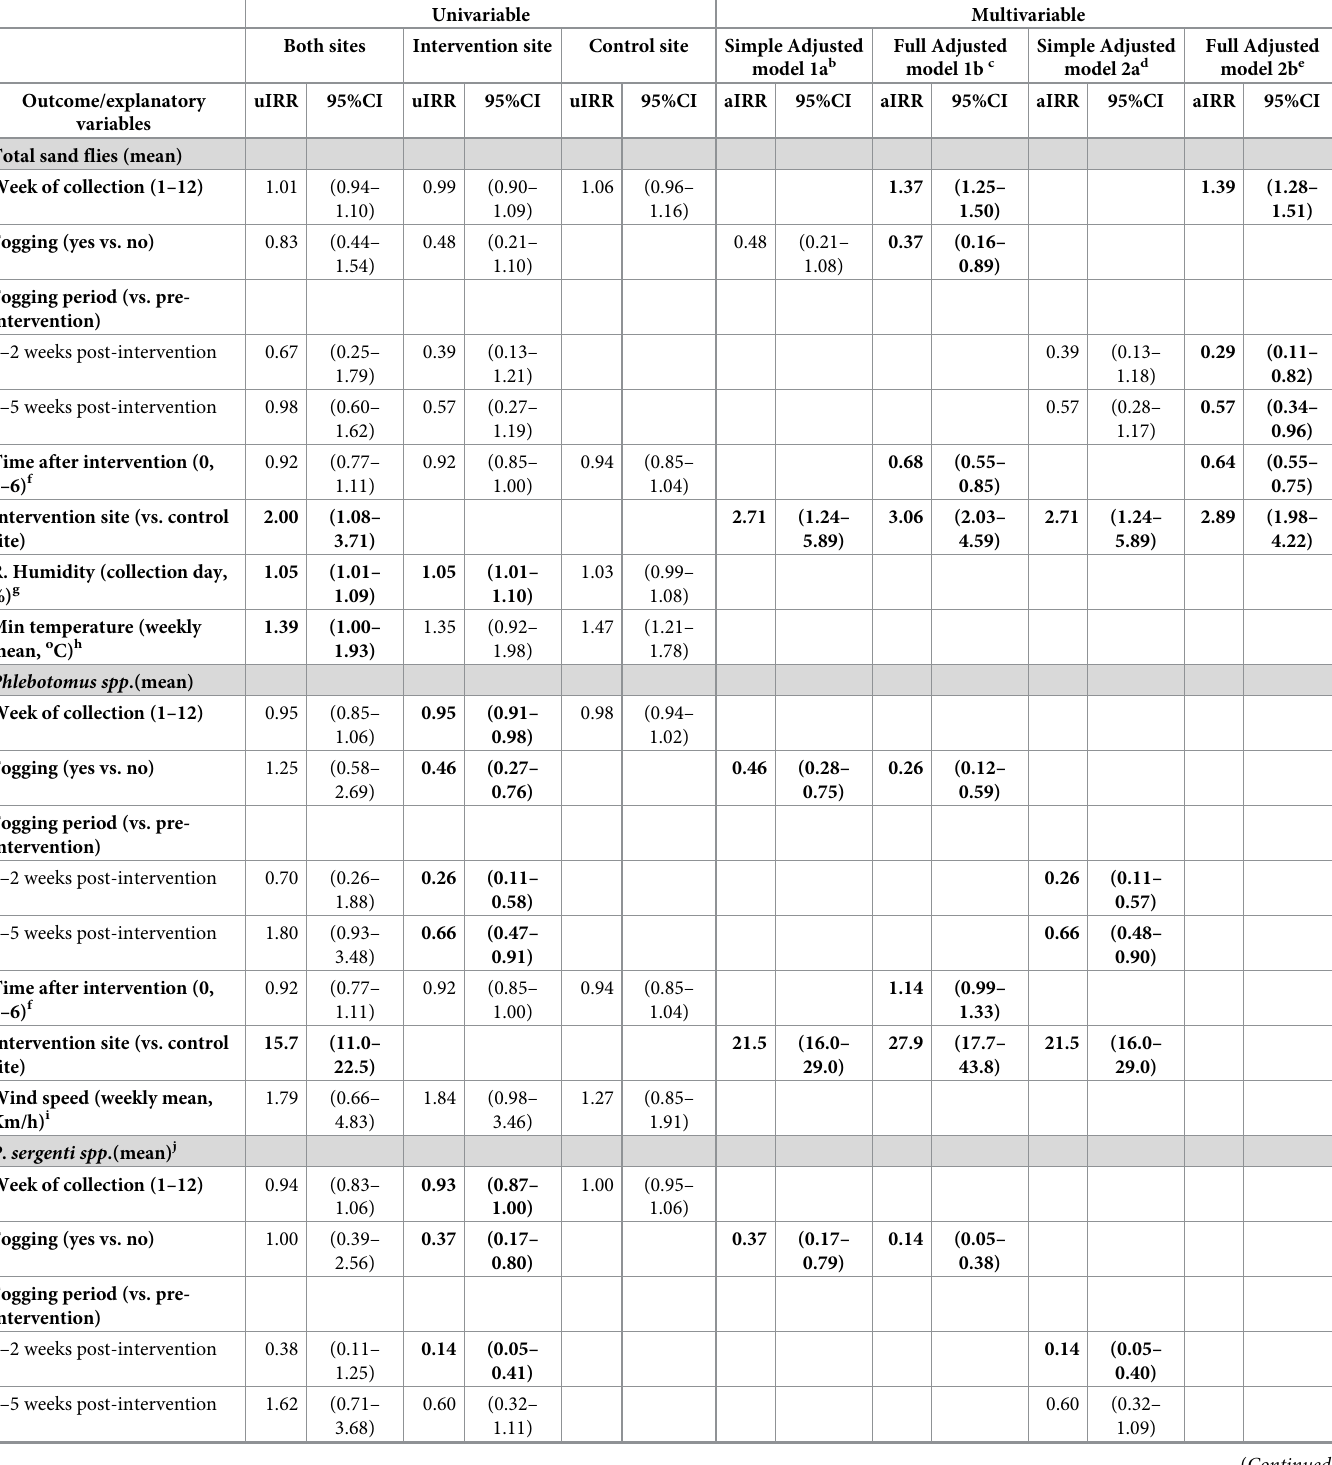
Table 5. Unadjusted (uIRR) and adjusted (aIRR) Incidence Rate Ratio and 95% Confidence Intervals (95%CI) in the intervention (intervention site) and control sites (control site) for factors associated with the main and secondary outcomes in negative binomial regression a , Tayasir, Palestine, June—September